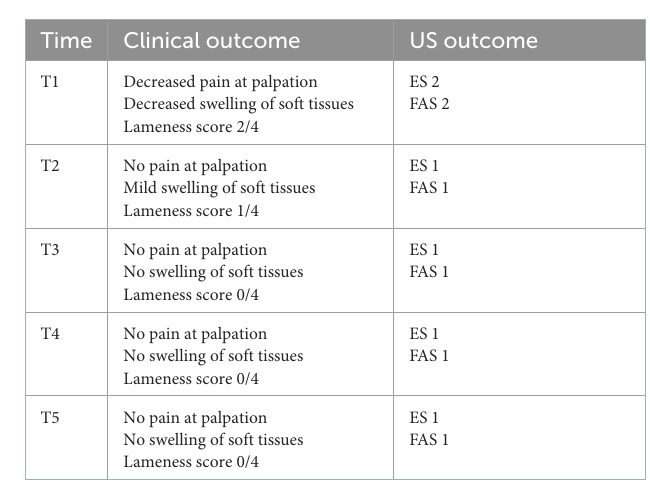
TABLE 3 Clinical and US outcomes from T1 to